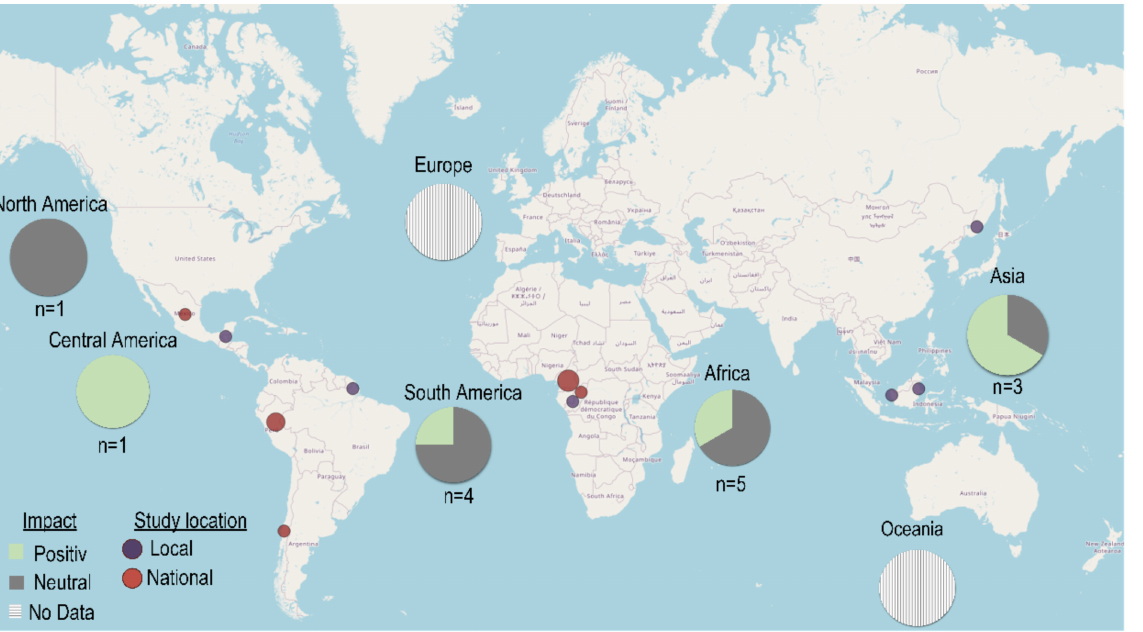
Figure 4. Global distribution of case studies on the impact of forest certification on deforestation. The size of the dots represents the relative number of case studies per location. Study location: Local studies are here equal or smaller than districts/states. National studies indicate that multiple case studies across the country were investigated. Pie charts show the number of case studies and the reported impact per region. Base map: ©